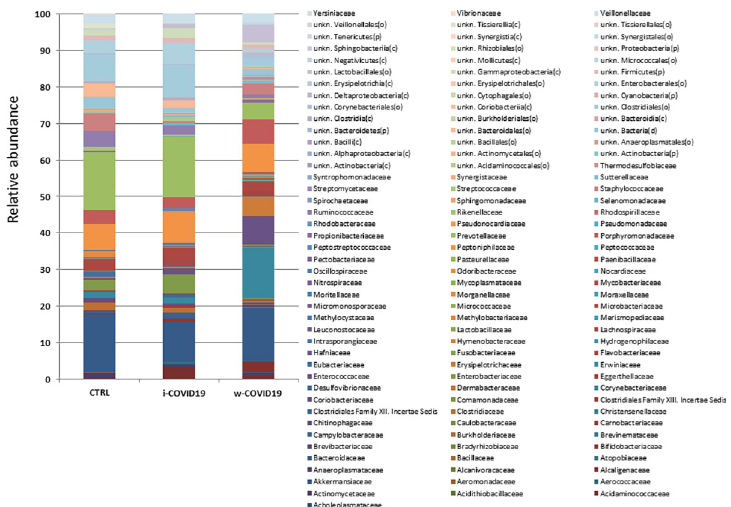
Fig 4. Microbiota composition of w-COVID19, i-COVID19 patients and CTRL, at the family level. The mean value of all the detected taxa is represented.